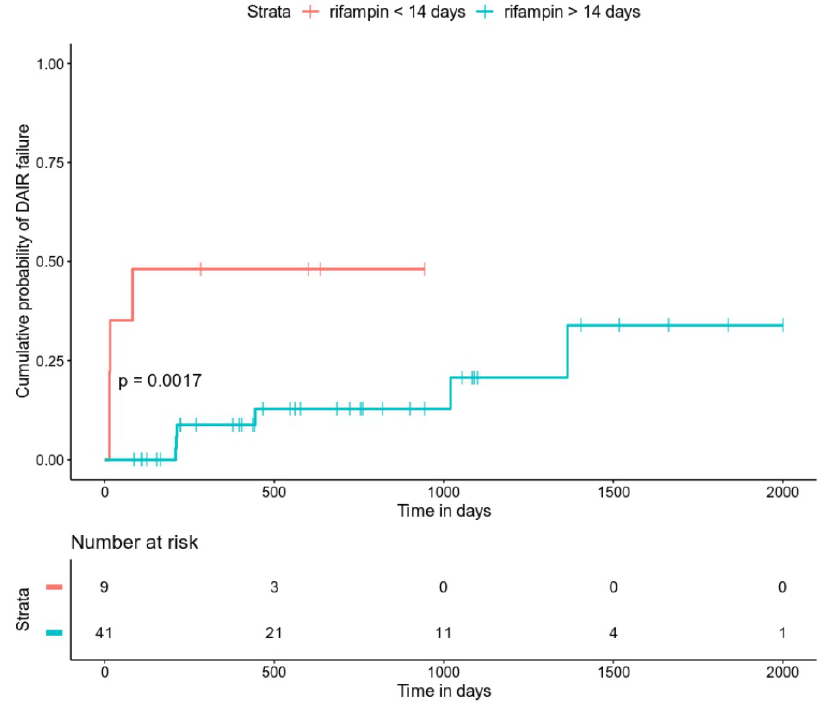
Figure 1. Kaplan Meier estimates of treatment failure probability in patients receiving less and more than 14 days of